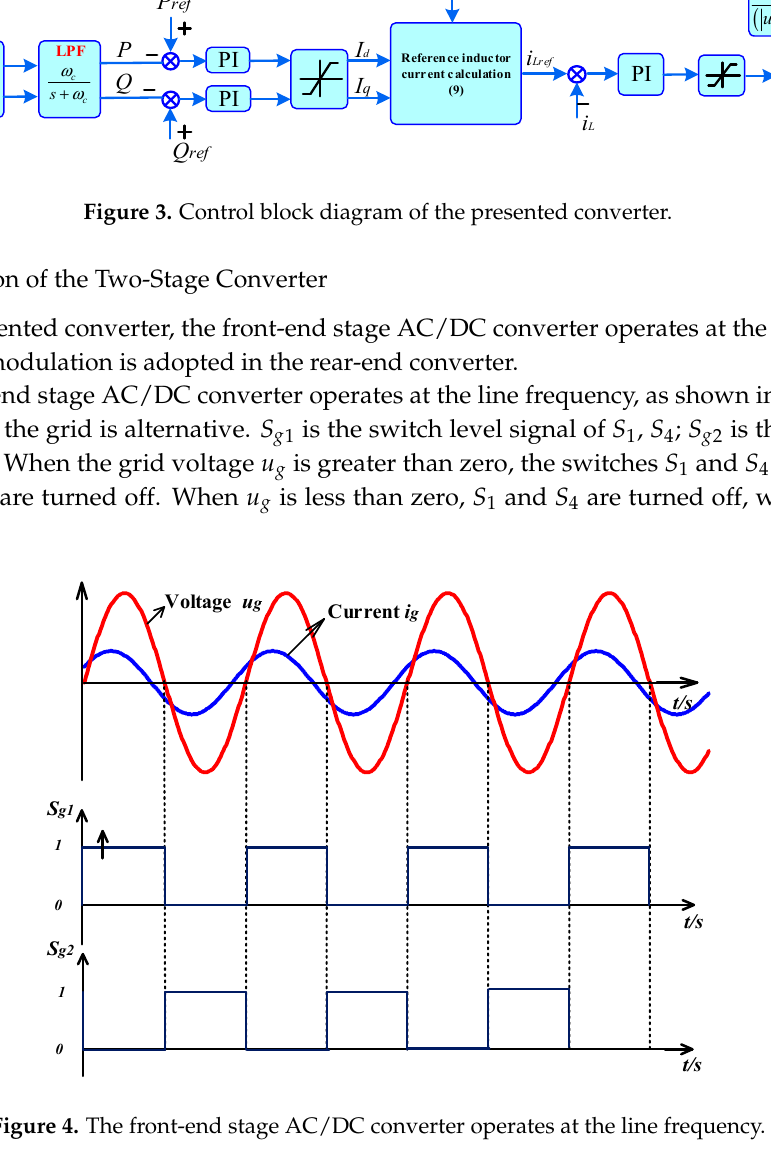
Figure 3. Control block diagram of the presented converter.